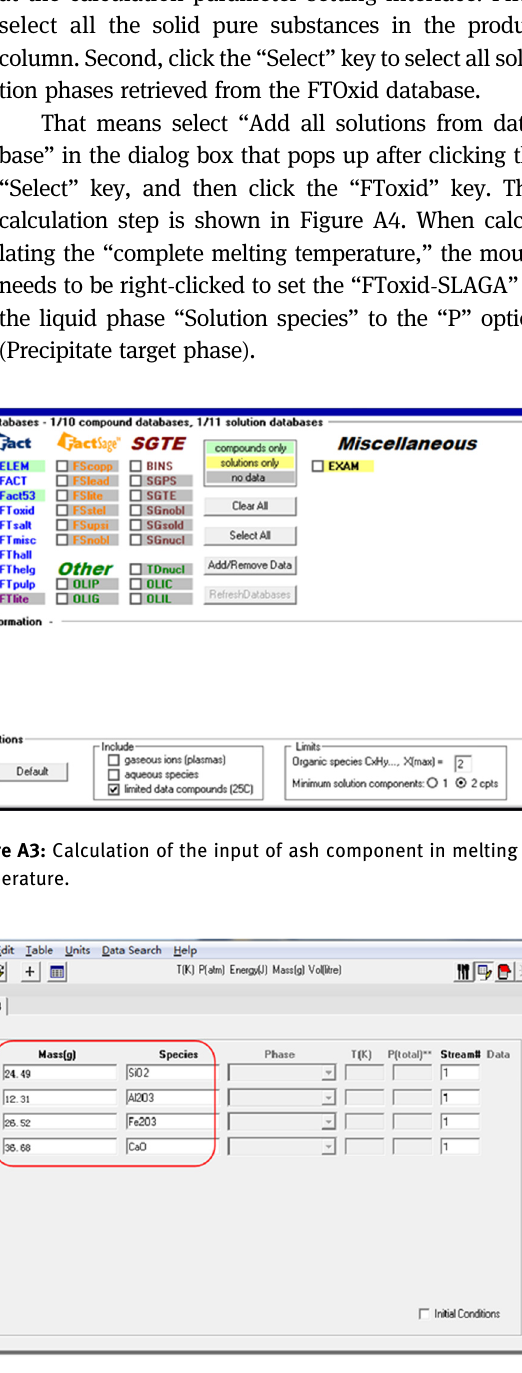
Figure A4: Selection of reaction products in calculation of melting temperature.